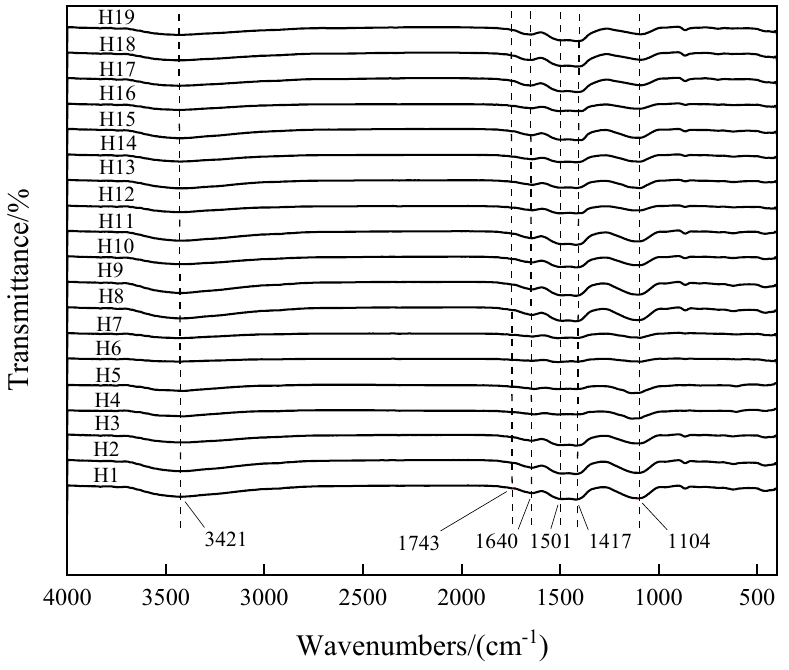
Figure 7. FT-IR spectra of freeze-dried DOM samples during the wet